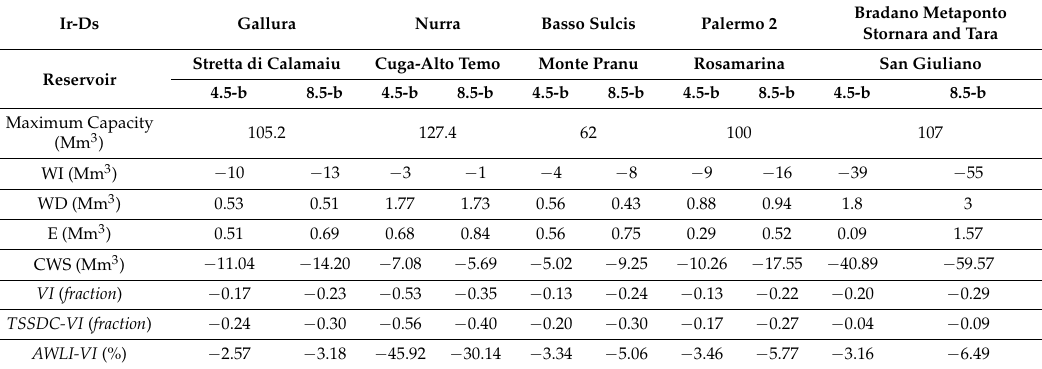
Table 8. Differences of annual water inflow ( WI ), crop water demand ( WD ), evaporation loss ( E ), cumulated water shortage (CWS), vulnerability index (VI), Temporal Self-sufficiency in Demand Capacity index (TSSDC), and Allowable Water Losses for Irrigation index (AWLI). Changes are reported between baseline (b, 1976–2005) and future (2036–2065) climate under RCP 4.5 and 8.5. Ir-Ds